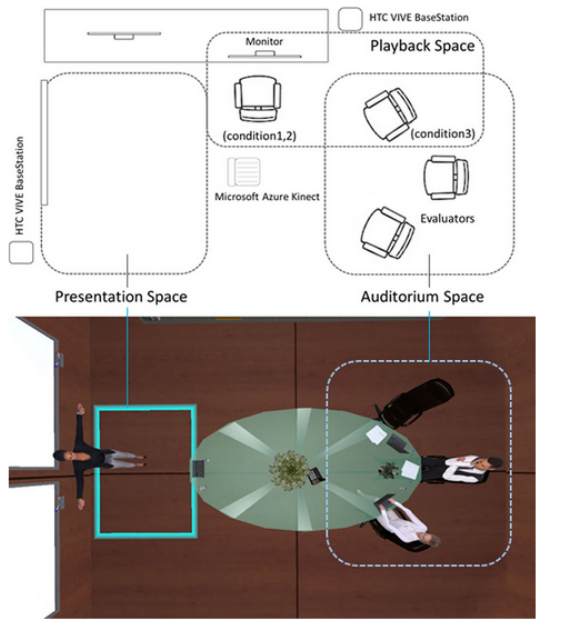
Figure 3. System setting. ( Top ): The setting in the real environment. ( Bottom ): The corresponding VR environment in the playback